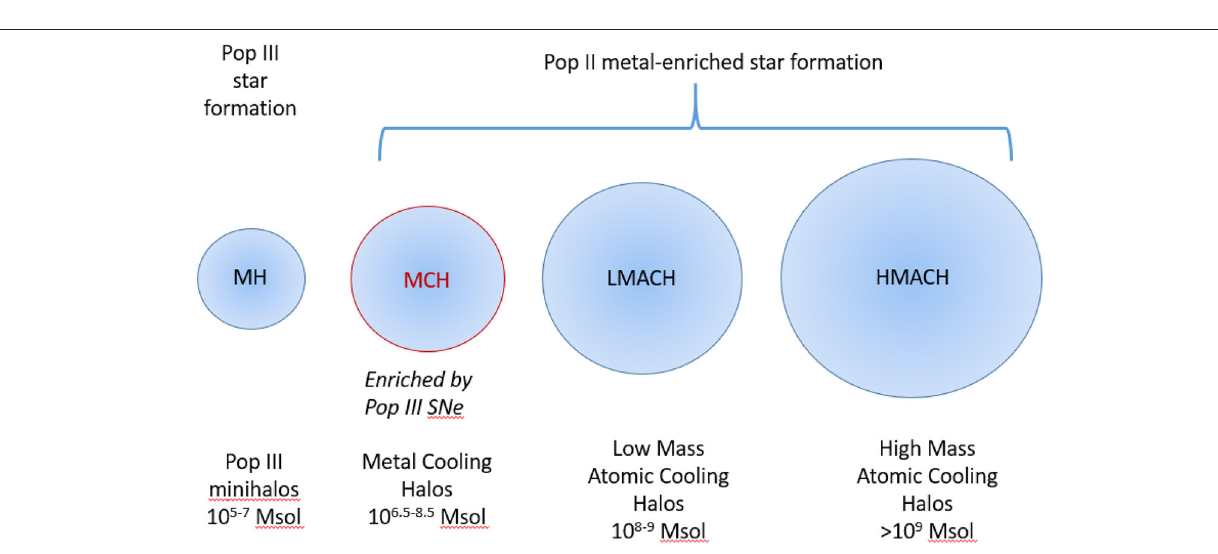
FIGURE 7 | Four types of star-forming halos of importance during the Cosmic Dawn. The MHs, LMACHs, and HMACHs have been well-discussed in the literature. The MCHs, discovered in the Birth of a Galaxy simulations, represent a new, potentially important